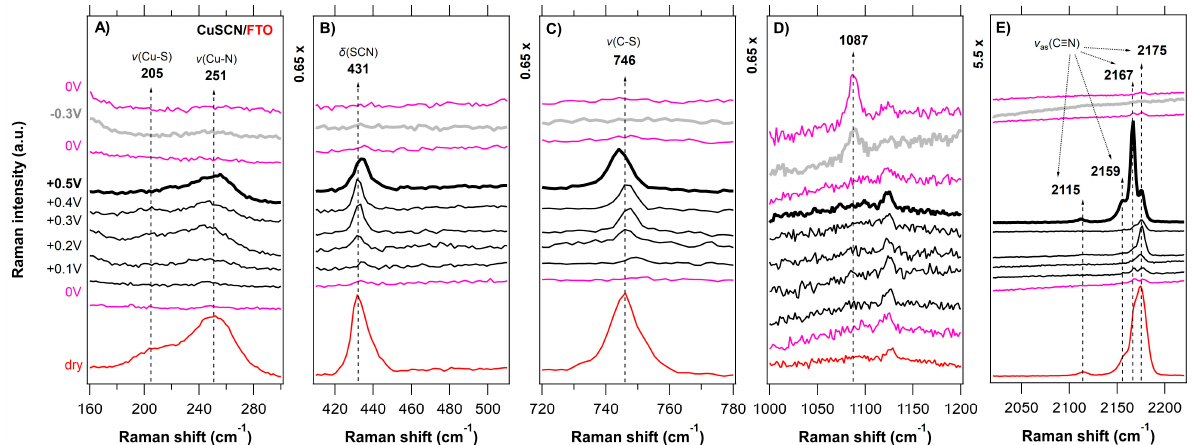
Figure 3. In situ Raman- µ SEC spectra of the CuSCN layer (spectral regions of 160–300, 410–510, 720–780, and 2020–2220 cm –1 in charts ( A ), ( B ), ( C ), and ( E ), respectively) electrodeposited on FTO substrate (spectral region of 1000–1200 cm –1 in chart ( D ) as a function of the applied potential (vs. Ag/AgCl; shown on the left-side chart) in 6 M LiCl. The measurement sequence was as follows; the first spectrum was acquired at 0 V (bottom pink trace) and the last spectrum was acquired again at 0 V (top pink trace). The sequence of positive potentials (from +0.1 V to +0.5 V) is visualized by black traces and the negative potential of –0.3 V is visualized by the gray trace. The reference (ex situ) Raman spectrum of the dry CuSCN layer on the FTO substrate is shown for comparison (bottom red trace). Spectra are offset for clarity; the intensity scale is identical for all the charts.